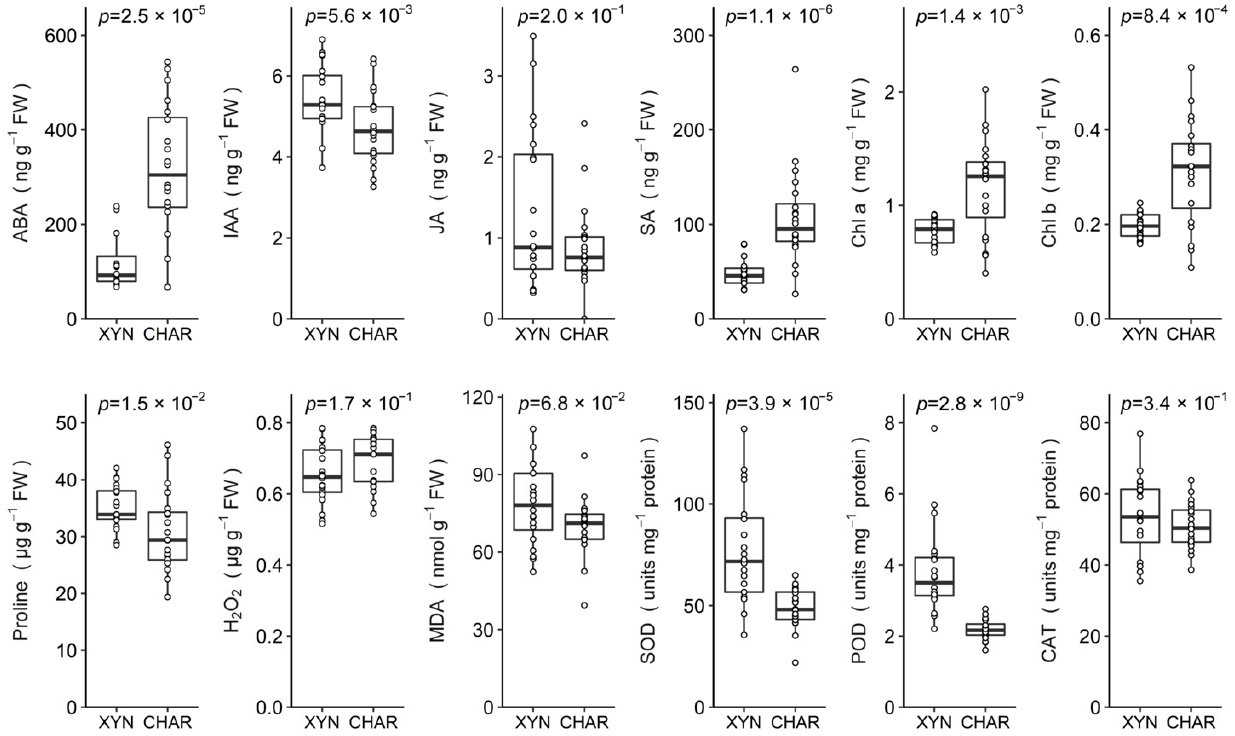
Figure 2. Basal levels of hormones, chlorophyll, and oxidative parameters in Xynisteri (XYN) and Chardonnay (CHAR). Samples from fully irrigated plants that were not inoculated with the pathogen were analyzed and pooled. The samples were collected from five plants of each cultivar at 7 and 14 days of full irrigation (previous exposure to full irrigation, before inoculation; see Figure 1) and at 9 and 16 days of full irrigation (control treatments of continued exposure to full irrigation; see Figure 1). The parameters are considered to be significantly different for both cultivars if the p -value is below 0.05 (Mann–Whitney U -test). All observations are shown as dots. The lines inside the box and the lower and upper boundaries of the box represent the median and first and third quartiles, respectively. The whiskers indicate the minimum and maximum values, excluding outliers. All observations outside the 1.5-fold interquartile range of the first or third quartile are considered outliers.